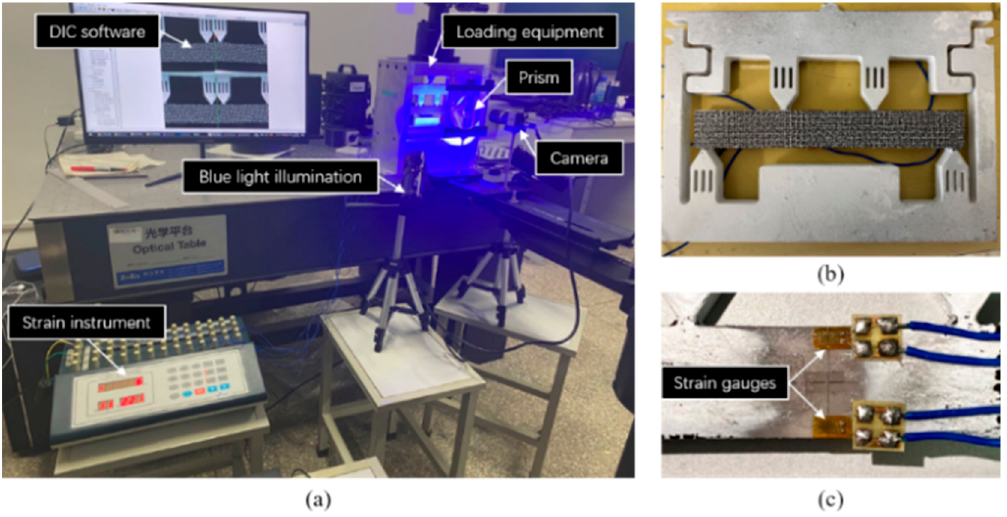
Figure 13. Four-point bending experiment: ( a ) experiment setup; ( b ) specimen; ( c ) strain gauge.